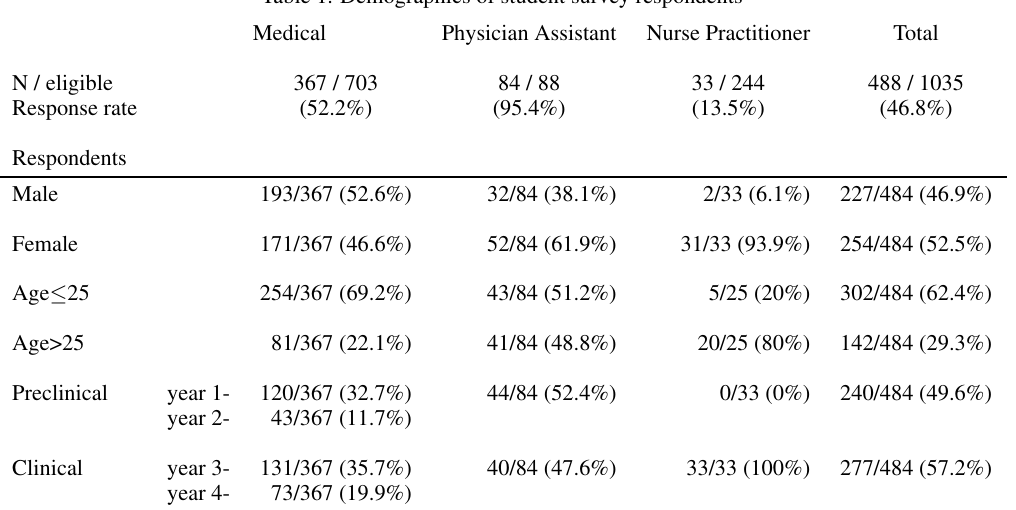
Table 1. Demographics of student survey